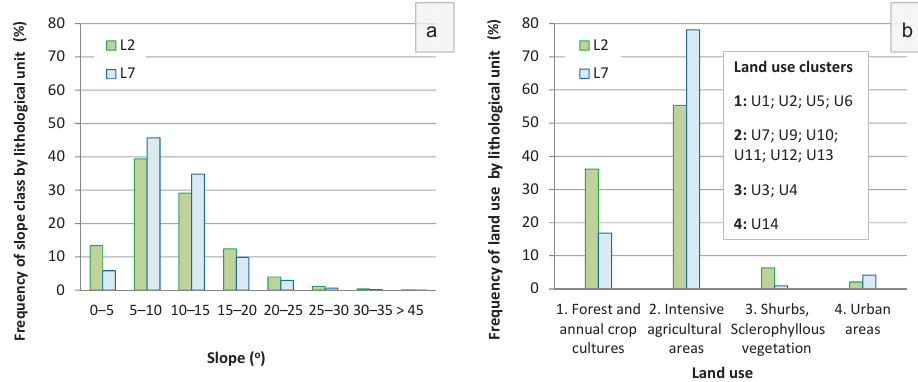
Figure 10. Frequency of slope (a) and land use clusters (b) within lithological units L2 and L7. Flat areas were not considered. Table 6. Contingency table extracted from the overlay of IV and IS shallow slide susceptibility maps in percent (%) of the study area. Numbered footnotes represent the susceptibility classes of the final map.